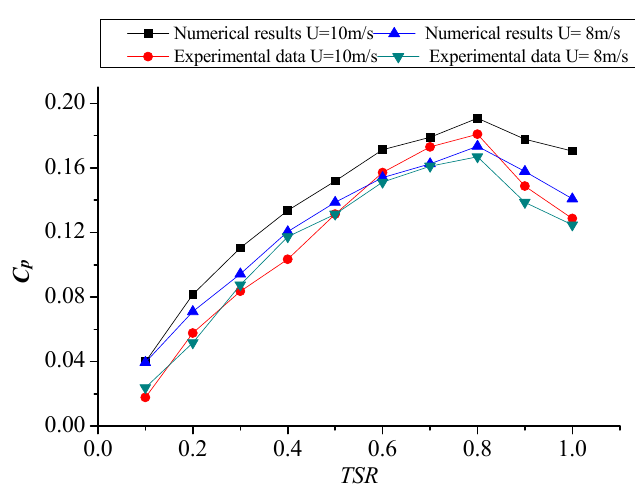
Figure 9. Variation of the power coefficient with the TSR.